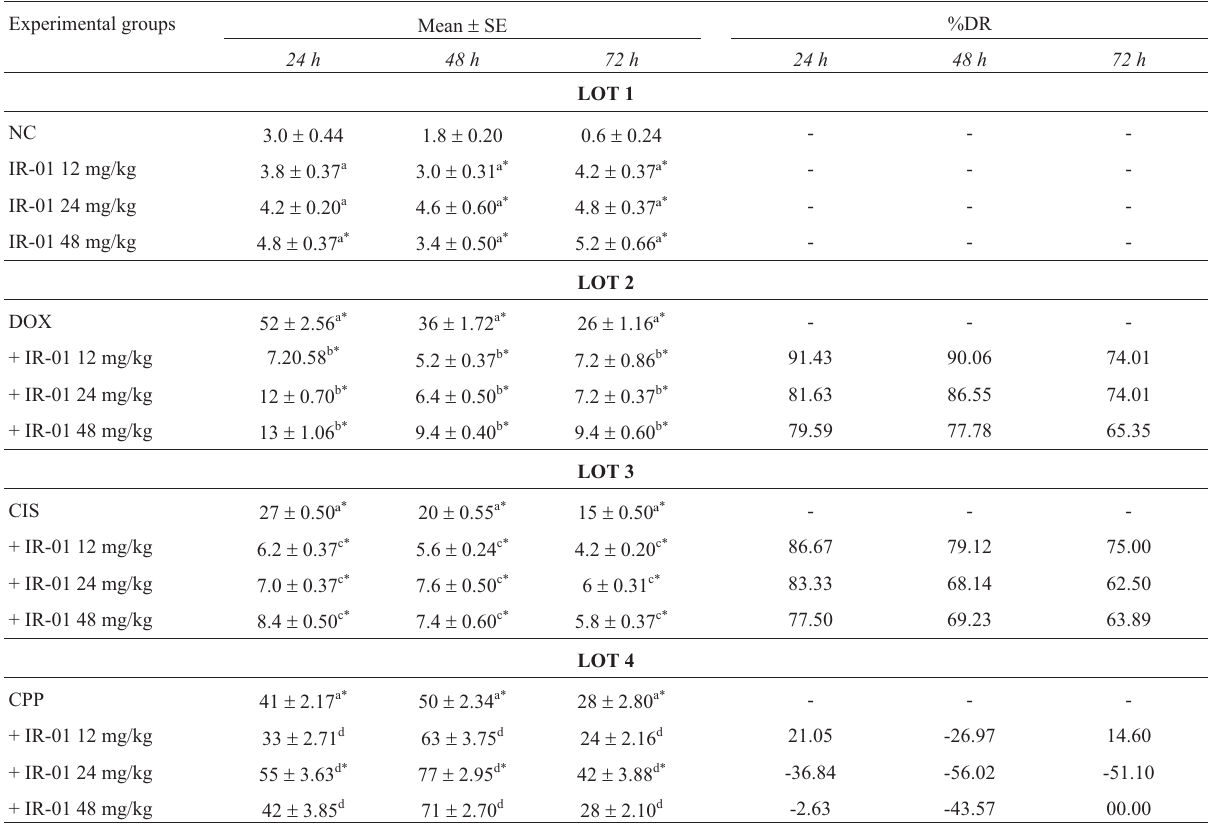
Table 2 - Results of the micronucleus assay related to the ability of IR-01 to cause or prevent chromosomal damage Experimental groups